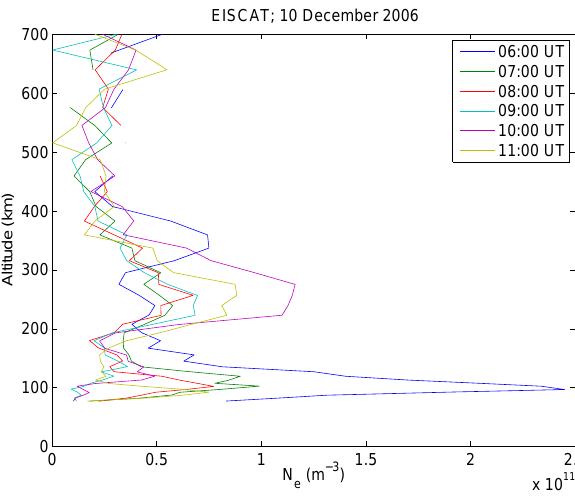
Fig. 4. The basic Chapman profiles used as default for vertical pro- file information in MIDAS. Fig. 5. Some examples of electron density profiles measured by the EISCAT incoherent scatter radar in